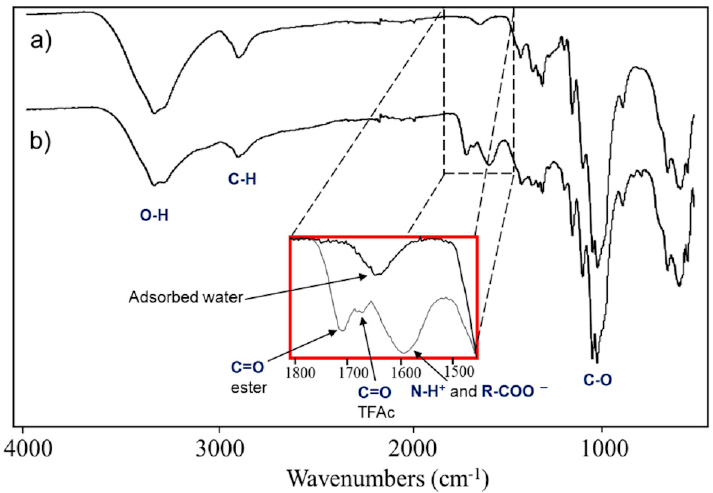
Figure 1. Fourier Transform Infrared spectra of: ( a ) Cellulose sample and ( b ) cellulose modified with N-trifluoroacetyl-L-aspartic anhydride (Cel-Asp-N-TFAc). FTIR spectra of cellulose and cellulose modified with N-Carbobenzyloxy-L-aspartic anhydride (Cel-Asp-N-Cbz) are depicted in Figure 2 a and b , respectively. Once again, the presence of the cellulose matrix is observed in both samples by the classical O-H, aliphatic C-H and C-O signals pattern as was described previously. A carbonyl signal located at 1700 cm − 1 is observed clearly in the inset region (1800–1500 cm − 1 ) of spectrum b, which could arise from the aspartic ester group on cellulose, as well as the urethane moiety of the N-protecting group Cbz. Furthermore, bands at 1588 and 1521 cm − 1 can be attributed to either carboxylate groups from the aspartic acid or to aromatic rings from Cbz. Figure 2. FTIR spectra of: a ) cellulose sample and b ) cellulose modified with N- carbobenzyloxy-L- aspartic anhydride (Cel-Asp-N-Cbz). Modified cellulose samples were also analyzed by 13 C solid state NMR. These spectra are shown in Figure 3 for Cel-Asp-N-TFAc and Figure 4 for Cel-Asp-N-Cbz. 13 C CPMAS NMR spectra of